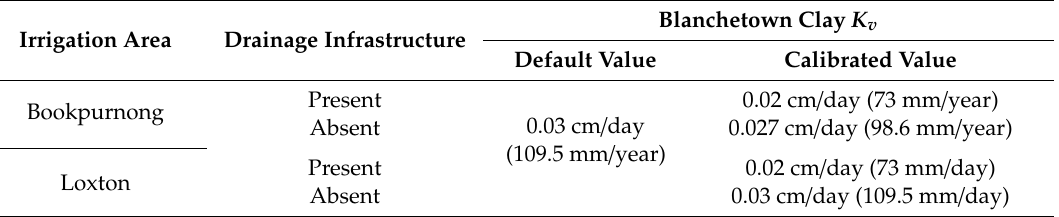
Table 2. Calibrated hydraulic conductivity ( K v ) of Blanchetown Clay from use of drainage